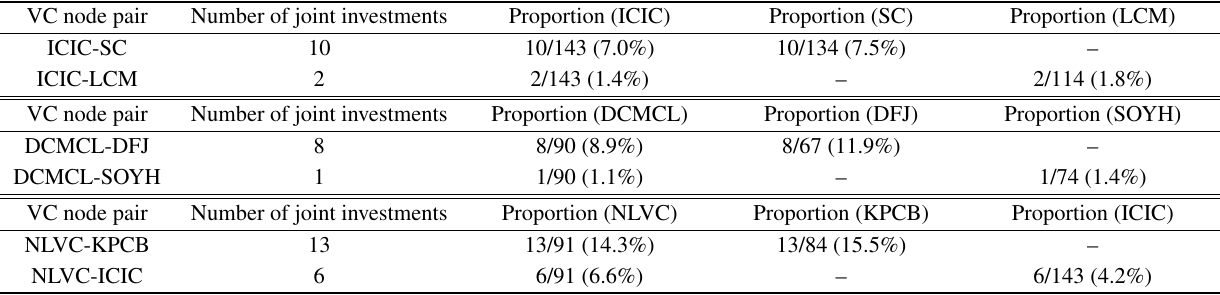
Table 12 Number of joint investments and its proportion of VC companies in relevant VC node constraint pairs. VC node pair Number of joint investments